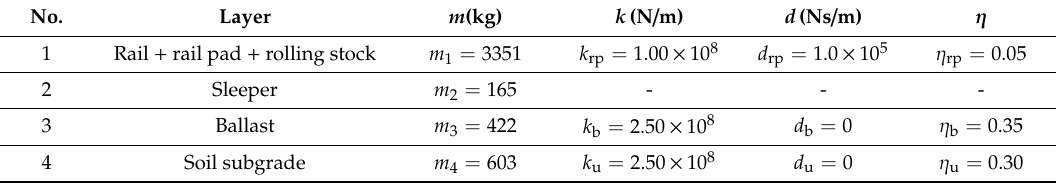
Table 3. Parameters of the 4DoF model—reference system.